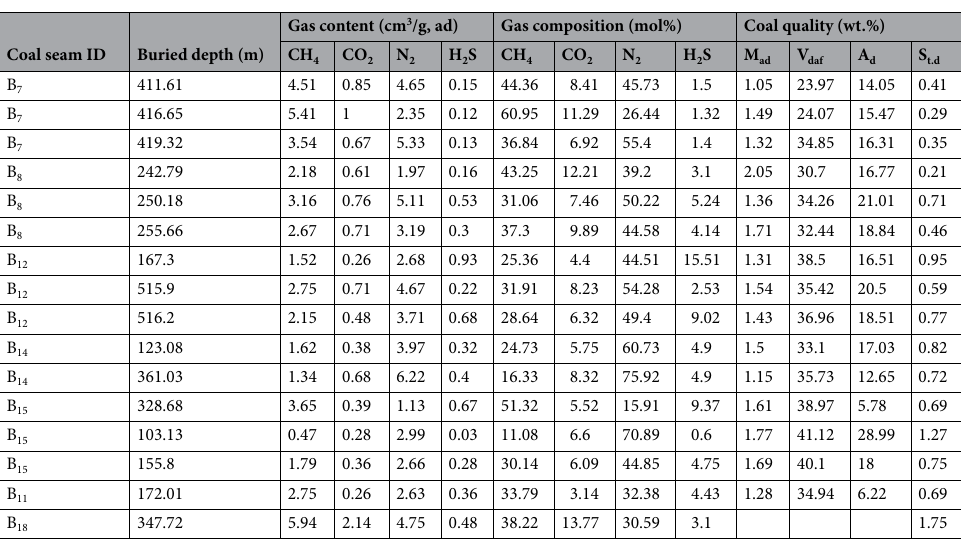
Table 1. Gas composition and the results of coal quality analysis. ad air-dried basis, M ad moisture of air-dried basis, V daf volatile of dry ash-free basis, A d ash of dry basis, S t.d total sulfur of dry